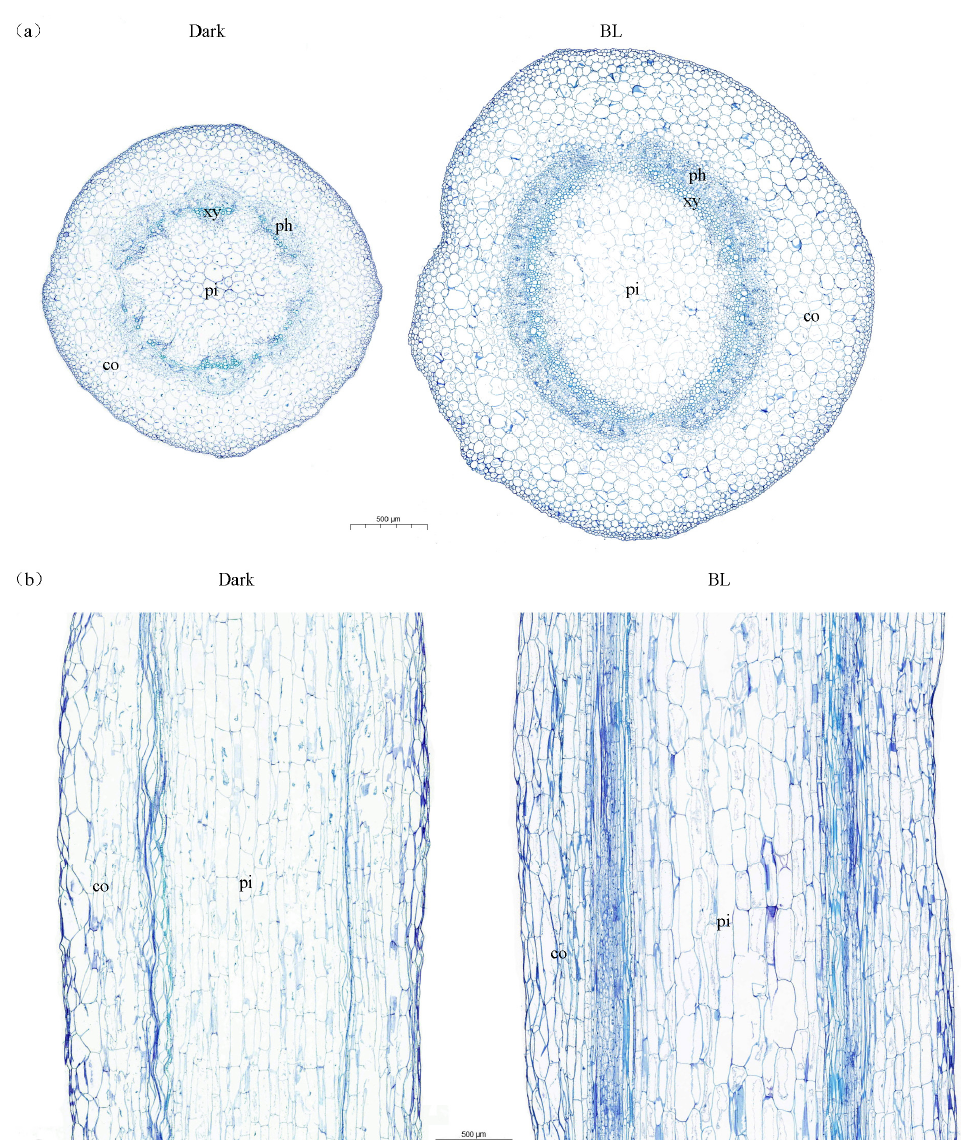
Figure 1. Transverse sections ( a ) and longitudinal sections ( b ) of soybean hypocotyls under dark and